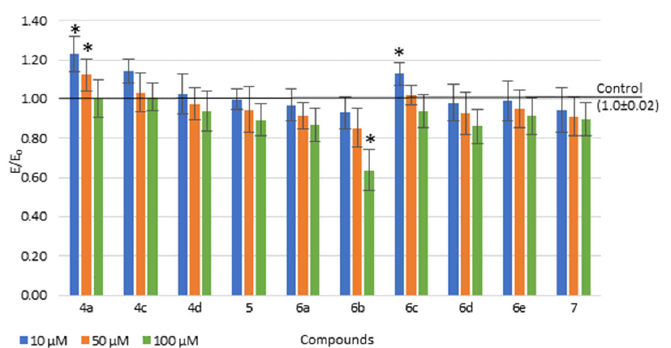
Figure 7. Effect of tested compounds on the viability of NHDF cells; * p < 0.05—significant difference compared to control.